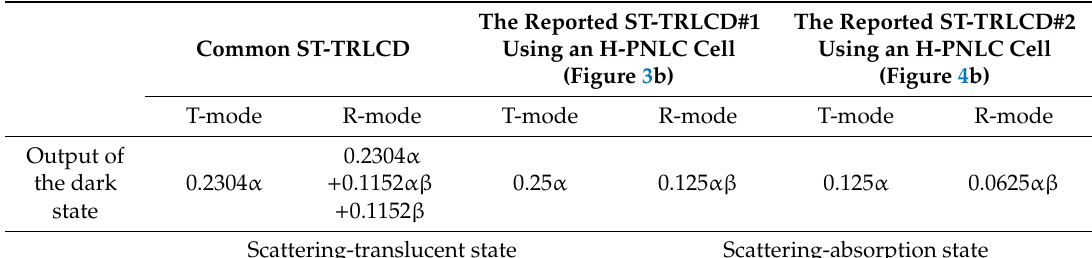
Table 1. Comparisons of dark state performances (output of the dark state) of both T- and R-modes of the three ST-TRLCDs ( α < β < 1). For detailed calculations, refer to the Appendix A.